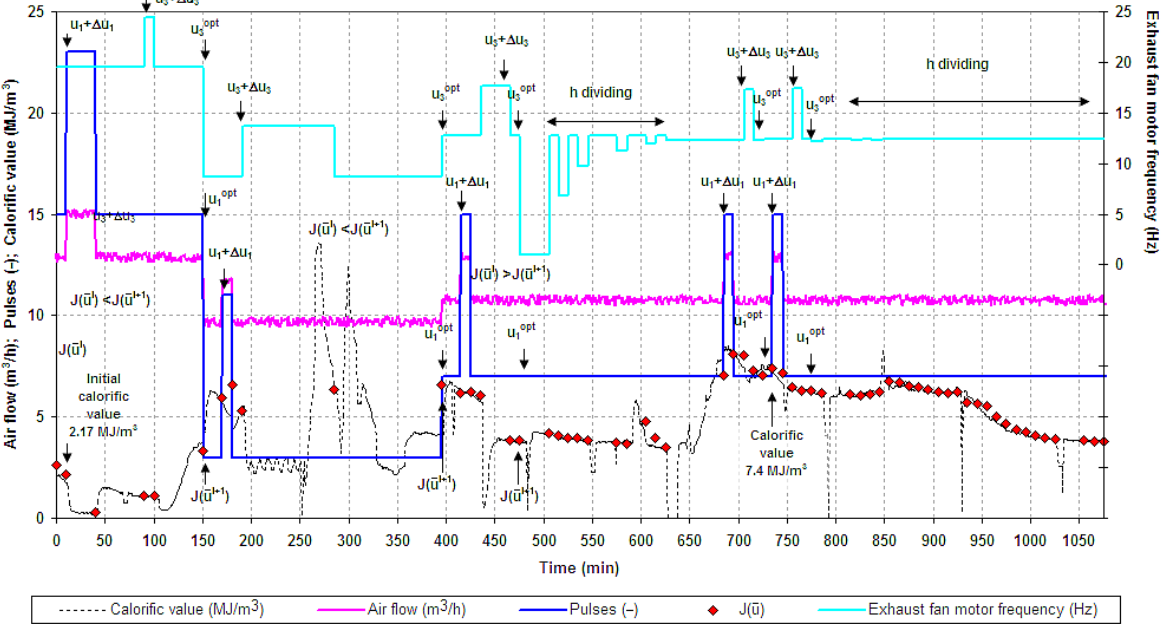
Figure 17. Maximization of syngas calorific value via optimization of two manipulation variables of UCG